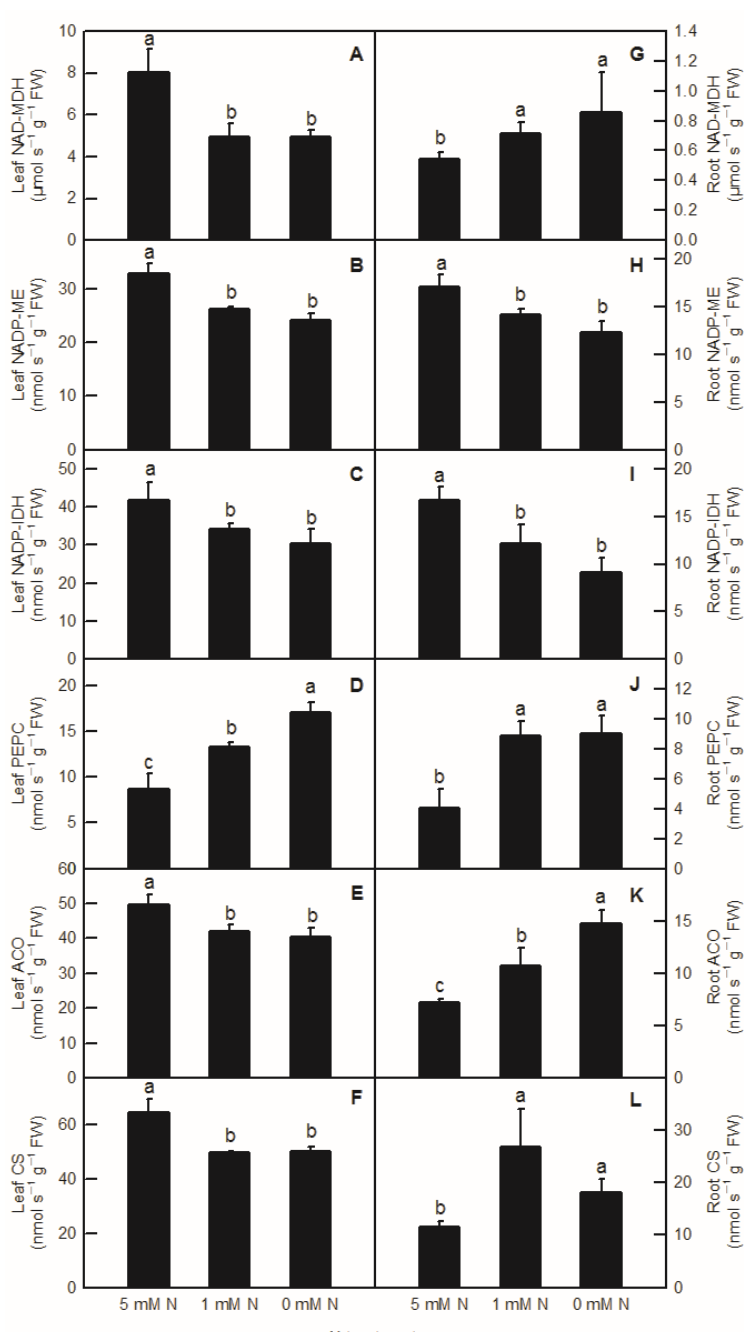
Figure 4. Effects of N deficiency on the activities of enzymes related to organic acid metabolism in O. sativa leaves ( A – F ) and roots ( G – L ). Bars represent means ± SD ( n = 3). Difference among the treatments was analyzed by Duncan’s multiple range test. Different letters above the bar indicate a significant difference at p < 0.05.